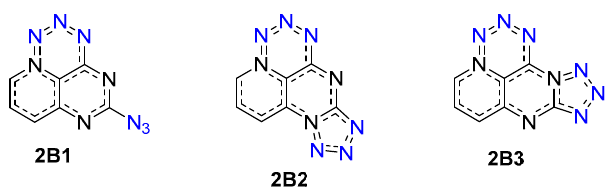
Figure 4. Tautomeric structures of diazide 2 .